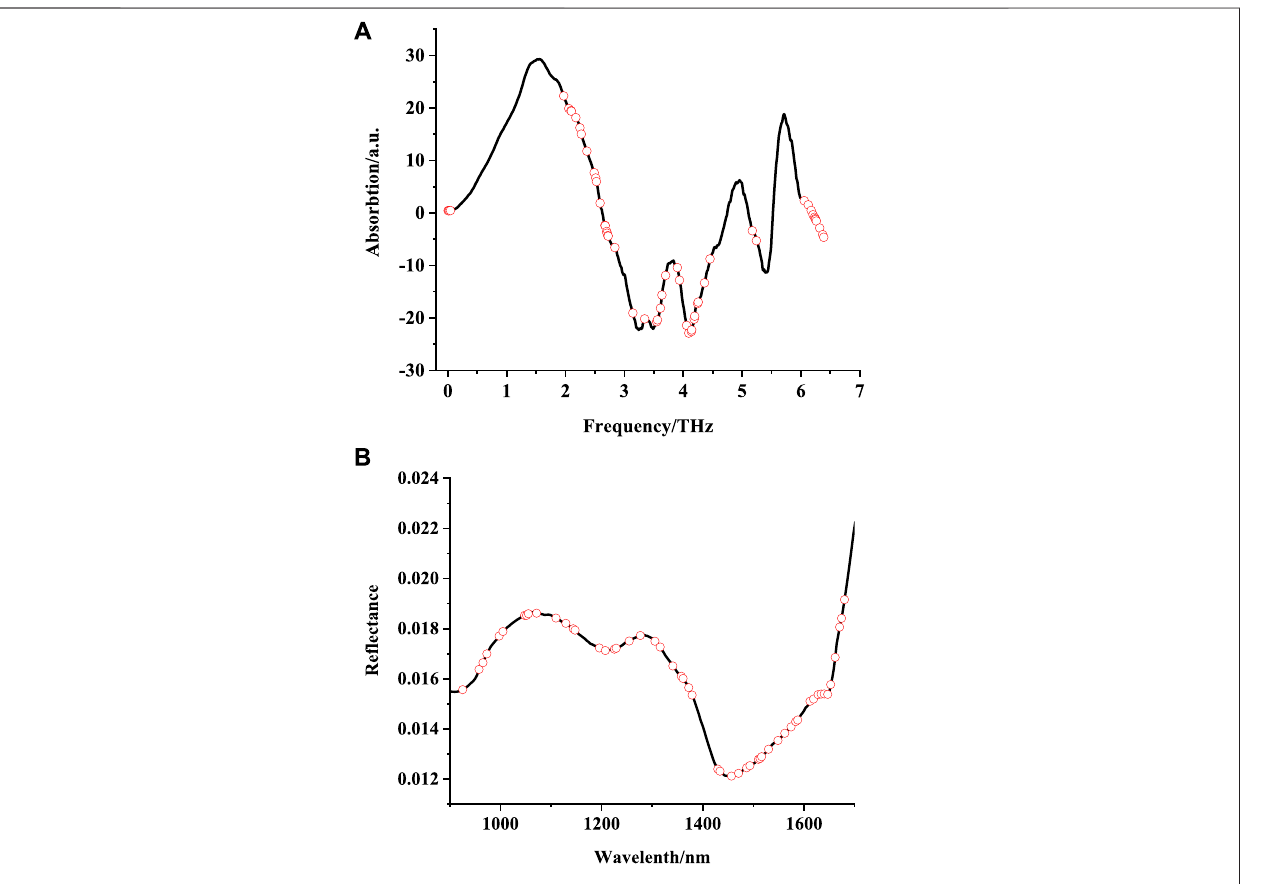
FIGURE 12 | (A) THz characteristic variable distribution; (B) NIR characteristic variable